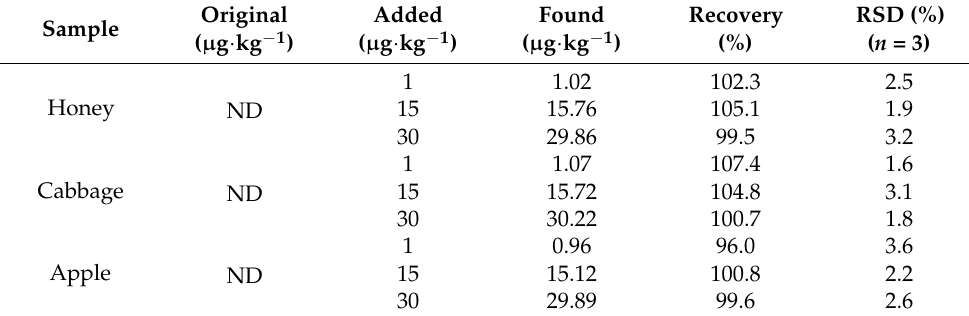
Table 3. Determination of carbaryl in food samples ( n =